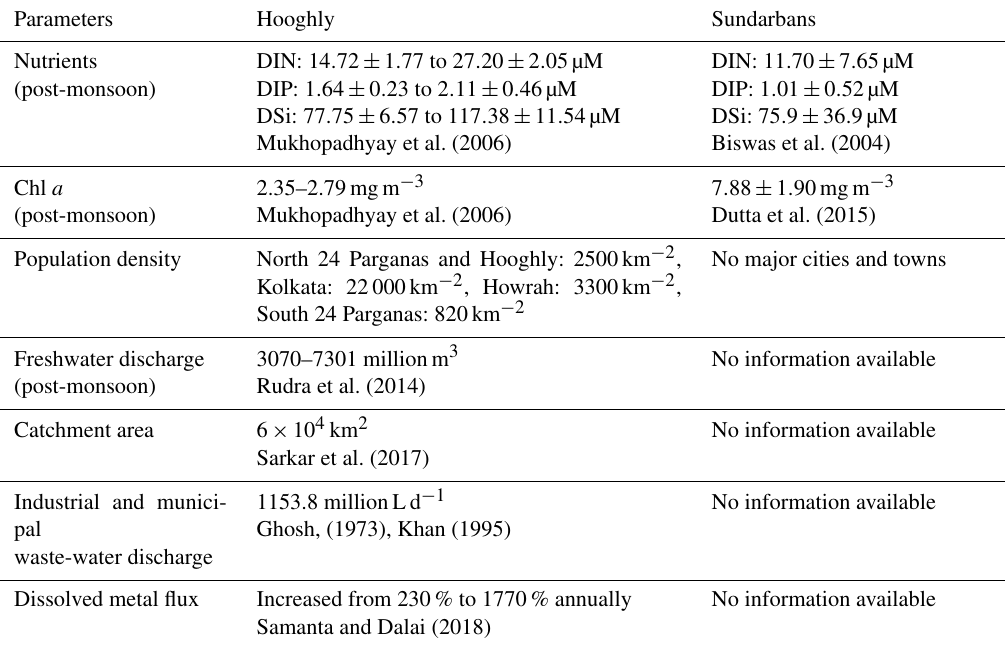
Table 1. General characteristics of the Hooghly estuary and the estuaries of the Sundarbans.